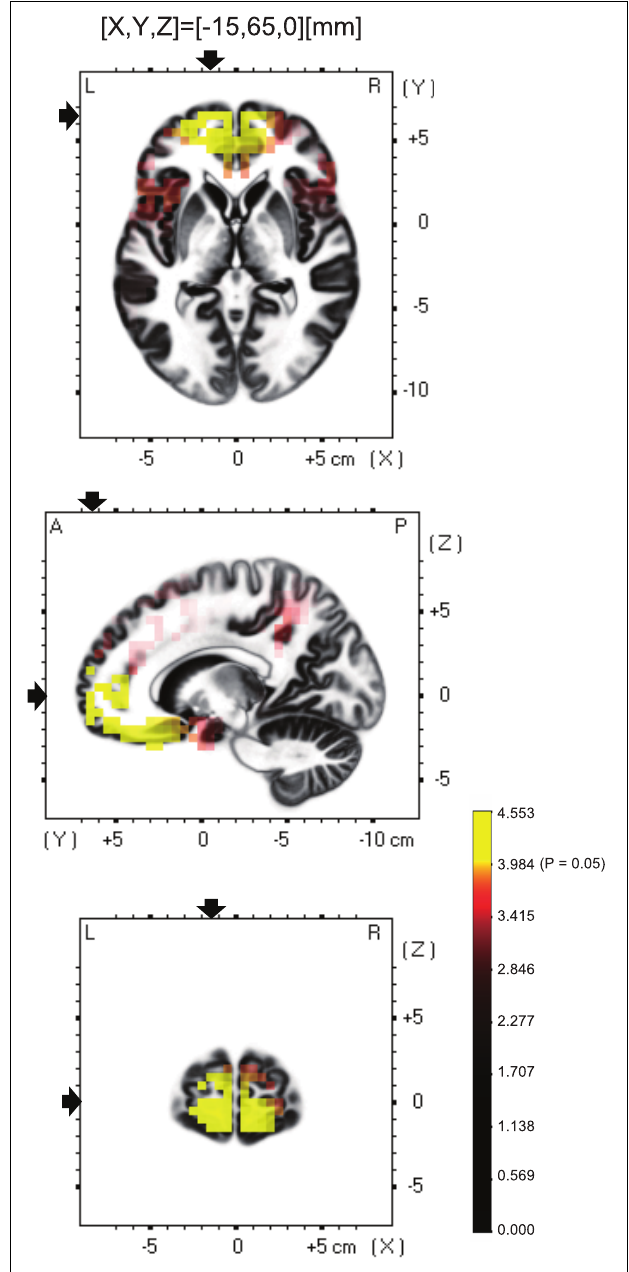
FIGURE 6 | Brain maps showing significant changes in CSD of theta oscillations during compression between the MTrP and non-MTrP groups. Yellow areas show brain voxels with significantly higher theta CSD in the MTrP group compared with the non-MTrP group ( P < 0.05). The black arrows indicate the 3D coordinates of the voxel with the highest CSD.